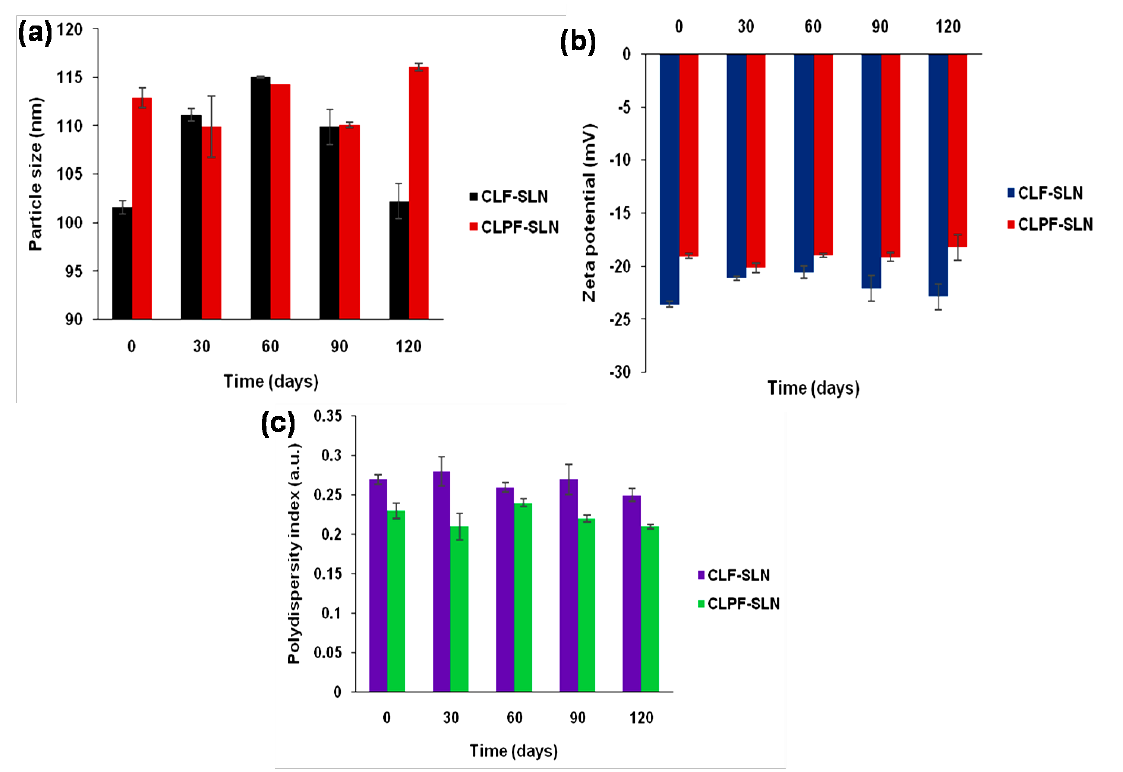
Figure 9. Characteristics of unloaded and PZQ-loaded CLF-SLN ( a ) Particle size, ( b ) zeta potential, ( c ) PDI at room storage temperatures over 120 days.